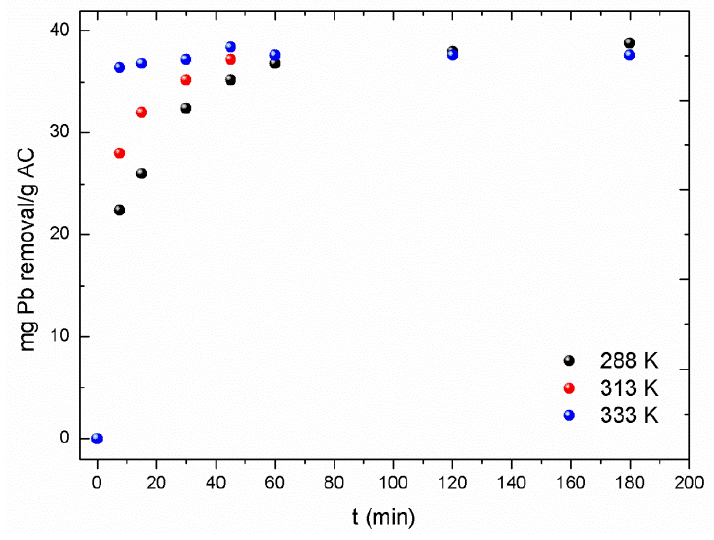
Figure 6. Influence of temperature on Pb 2+ removal from the aqueous solution. Stirring rate: 750 rpm.